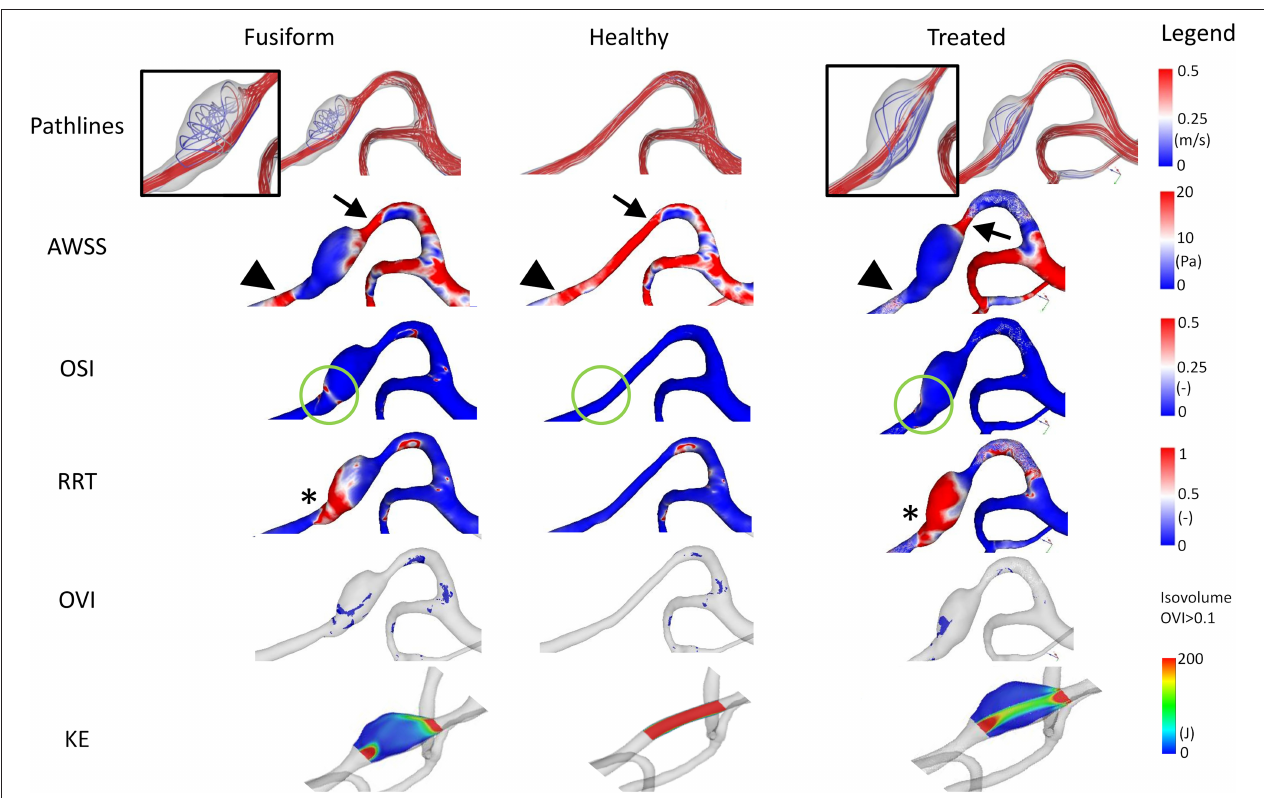
FIGURE 3 | Illustration of the hemodynamic results for Case 1. Fusiform (left) denotes the 3D model of the FIA; Healthy (center) the manually-created healthy counterpart; Treated (right) the 3D model after virtual stenting. The following flow- and shear-related parameters are presented from top to bottom: Pathline visualization, AWSS , OSI , RRT , OVI , KE . For illustration purposes, view points are not always identical but chosen such that the most interesting features are visualized.